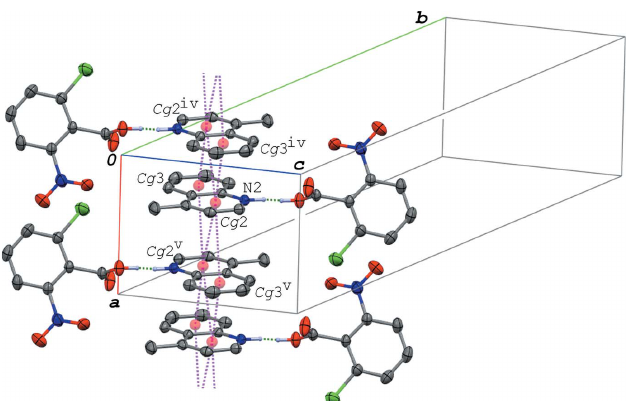
Figure 7 A packing diagram of (III), showing the column structure of the base molecules formed via the (cid:2) – (cid:2) interactions (magenta dashed lines). H atoms not involved in the O—H (cid:2)(cid:2)(cid:2) N/O (cid:2)(cid:2)(cid:2) H—N hydrogen bonds (green dashed lines) and the disordered O atoms of the minor component of the nitro group are omitted for clarity. Cg 2 and Cg 3 are the centroids of the N2/C8–C11/C16 and C11–C16 rings, respectively. [Symmetry codes: (iv) (cid:3) x , (cid:3) y , (cid:3) z + 1; (v) (cid:3) x + 1, (cid:3) y , (cid:3) z + 1.]